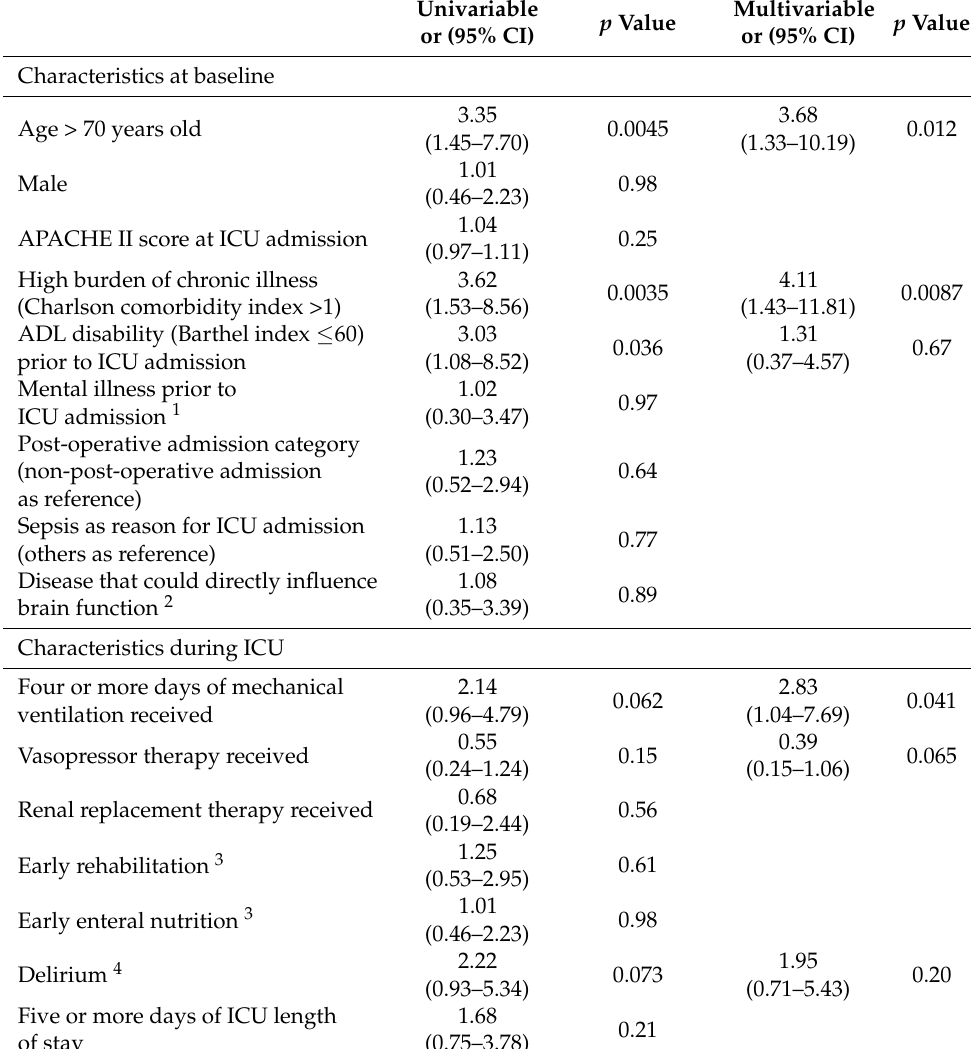
Table 2. Predictors for worsened ADL status at three months after intensive care unit